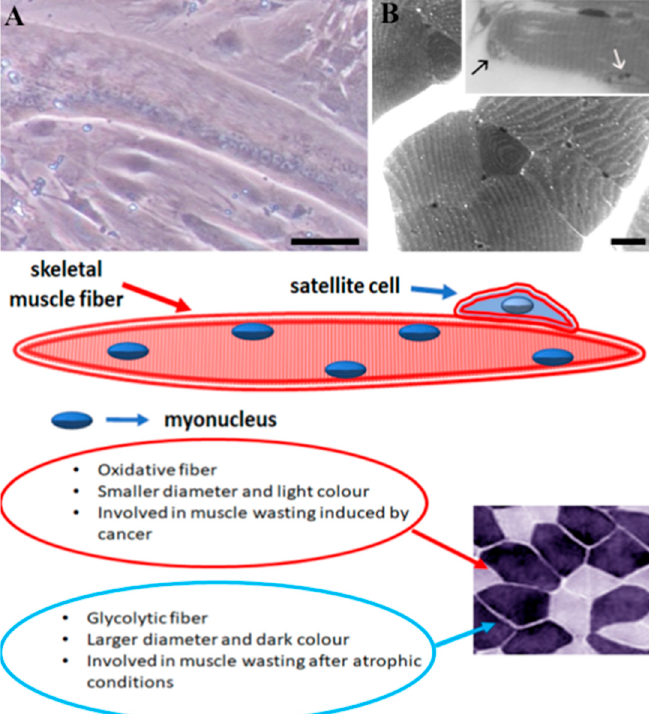
Figure 1. Image ( A ) shows a long and cylindrical adult myotube with several myonuclei located at the periphery of the fiber. Transverse ( B ) and longitudinal (inset B) optical sections of mouse muscle fibers where a satellite cell (black arrow) is located beneath the sarcolemma and basal lamina and a myonucleus (white arrow) is located at the periphery of the fiber in the space between myofibrils and sarcolemma. A schematic representation of a muscle fiber and inset photo where glycolytic and oxidative myofibers can be observed. Bars: 10 µm for A and 25 µm for B.